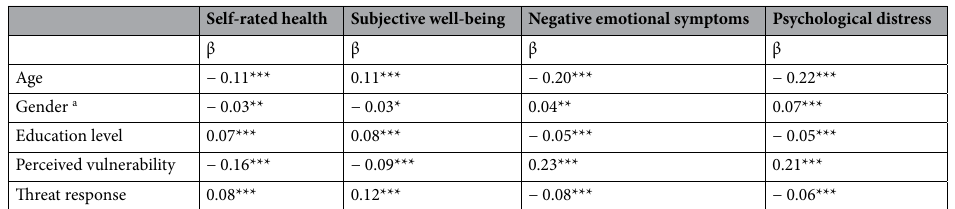
Table 5. Multilevel regression predicting well-being outcomes by perceived vulnerability and threat response at the individual level. * p < 0.05, ** p < 0.01, *** p < 0.001. a Male = reference group.